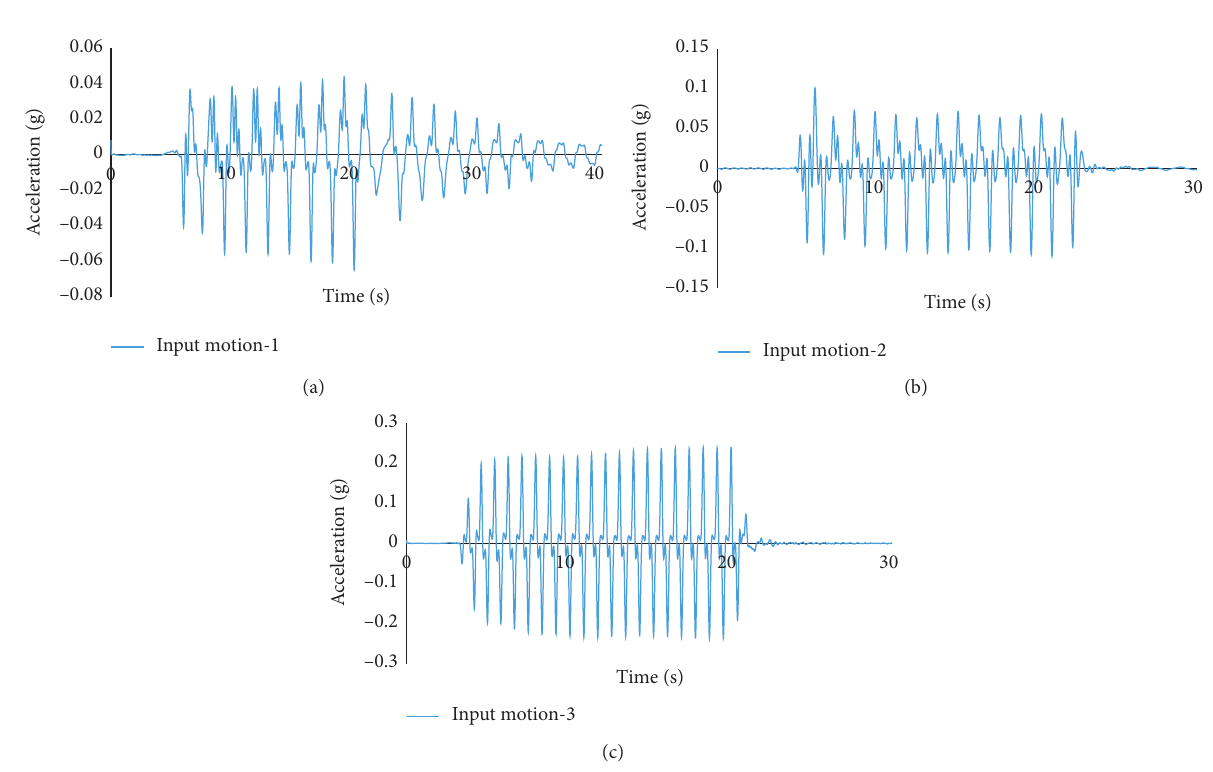
Figure 8: Input base accelerations: (a) input motion-1, (b) input motion-2, and (c) input